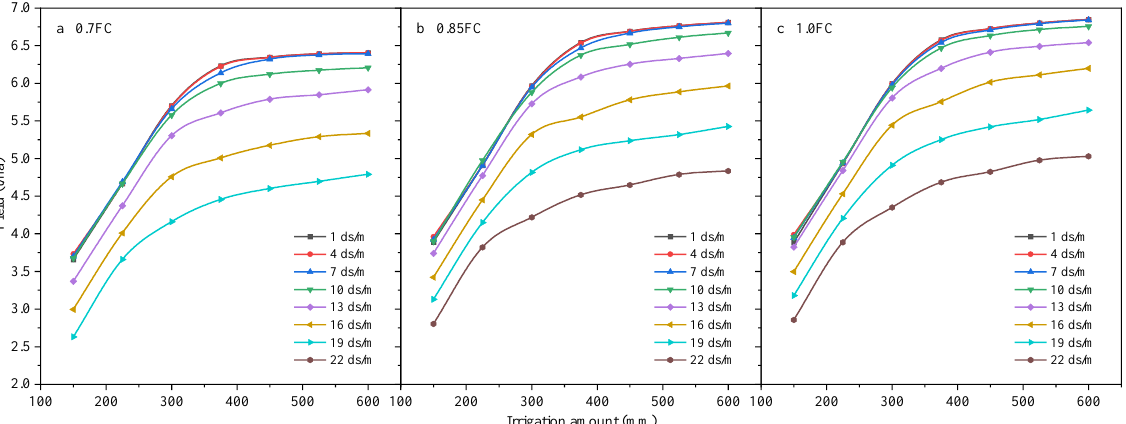
Figure 15. Relationship between irrigation amount and cotton yield under the scenarios of initial SWC (soil water content) and soil salinity at the different FC (field capacity). ( a ) 0.7 FC, ( b ) 0.8 FC and ( c ) 1.0 FC.